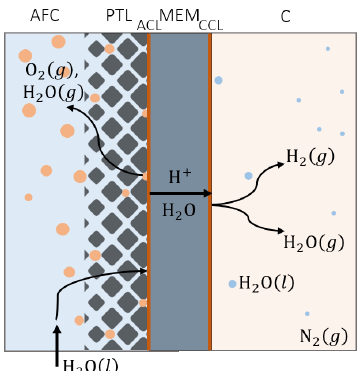
Figure 1. Schematic representation of the PEMWE: AFC—anode flow channel, PTL—anode porous transport layer, ACL—anode catalyst layer, MEM—membrane, CCL—cathode catalyst layer, C—cathode flow channel, g —gas, l